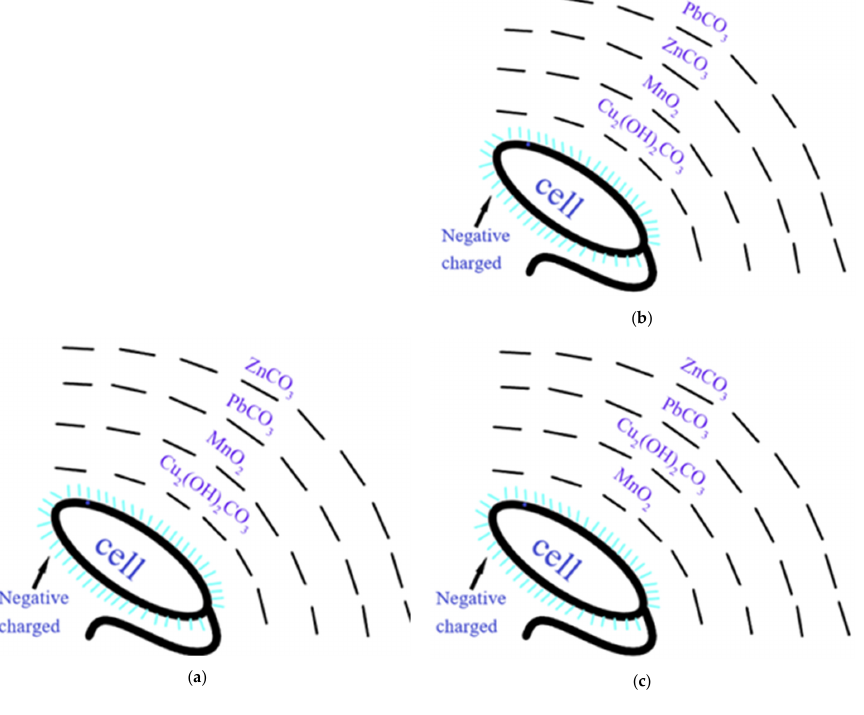
Figure 6. Layered precipitation structure hypothesis diagram. ( a ) Group A; ( b ) Group B; and ( c ) Group C.